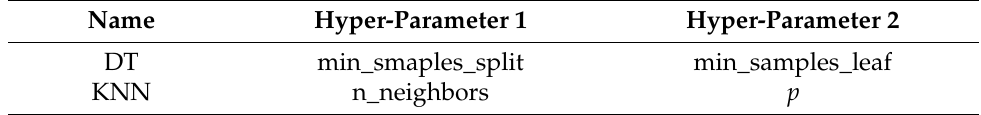
Table A1. ML algorithms together with hyper-parameters we have